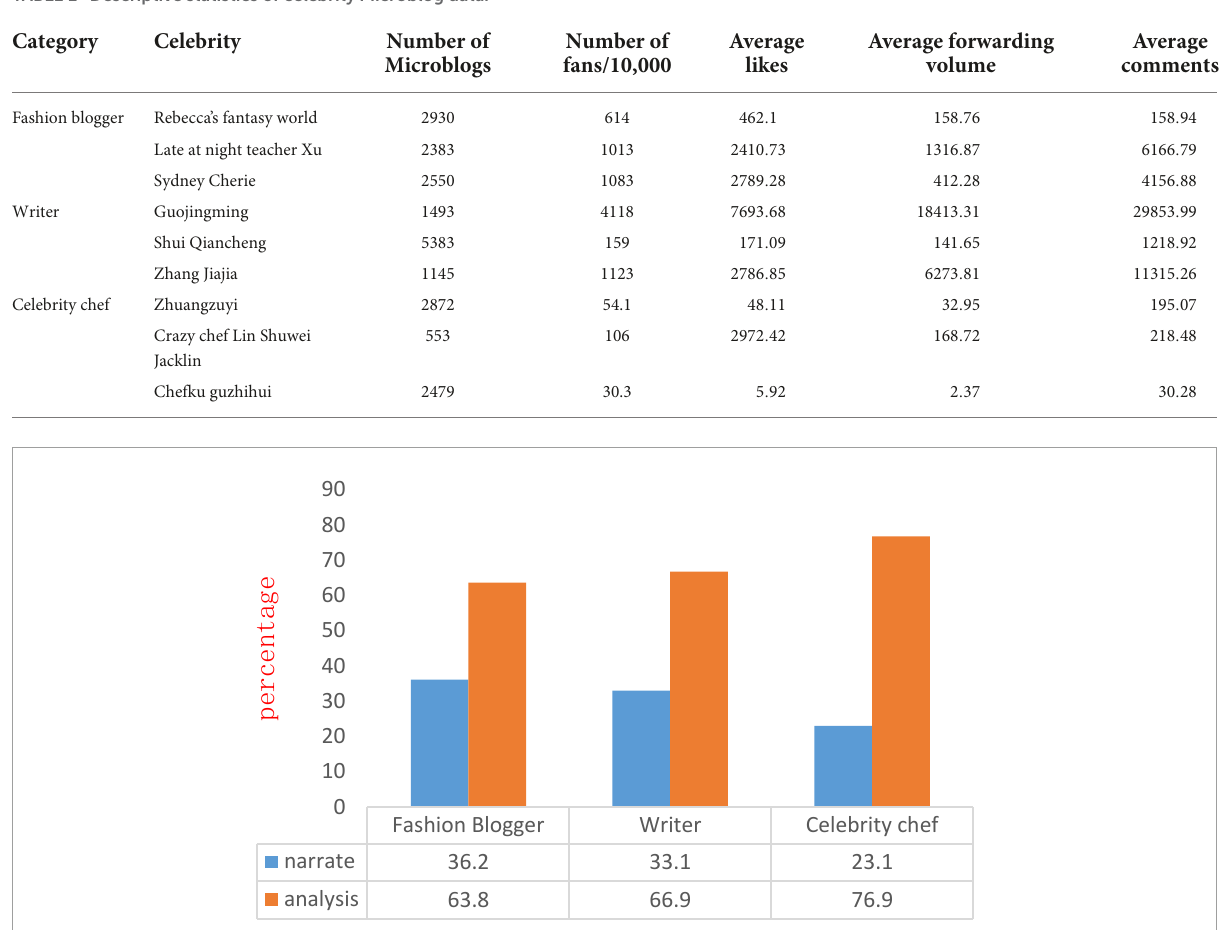
FIGURE2 The ratio of narrative and analytical styles for each category of celebrities and all celebrities.